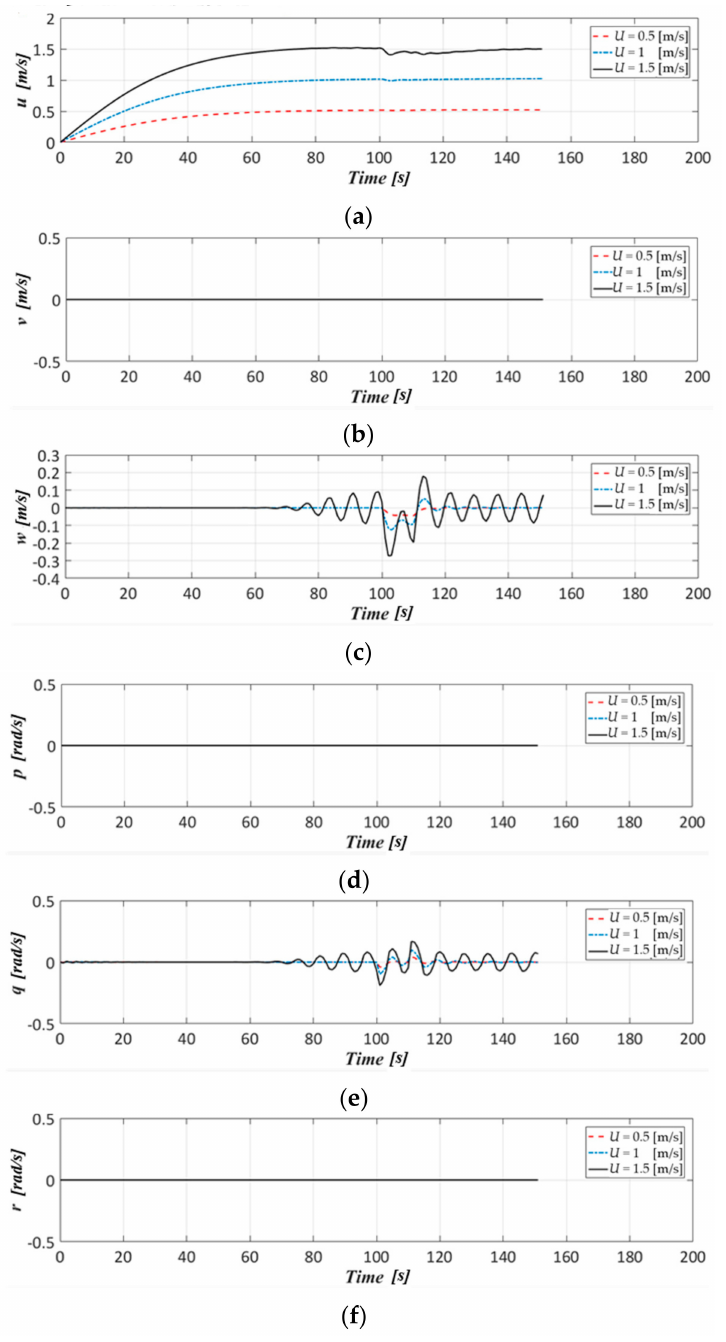
Figure 23. Time series of 6-DOF velocity components in the meander test. ( a ) Surge rate: u [m/s], ( b ) sway rate: v [m/s], ( c ) heave rate: w [m/s], ( d ) roll rate: p [rad/s], ( e ) pitch rate: q [rad/s], and ( f ) yaw rate: r